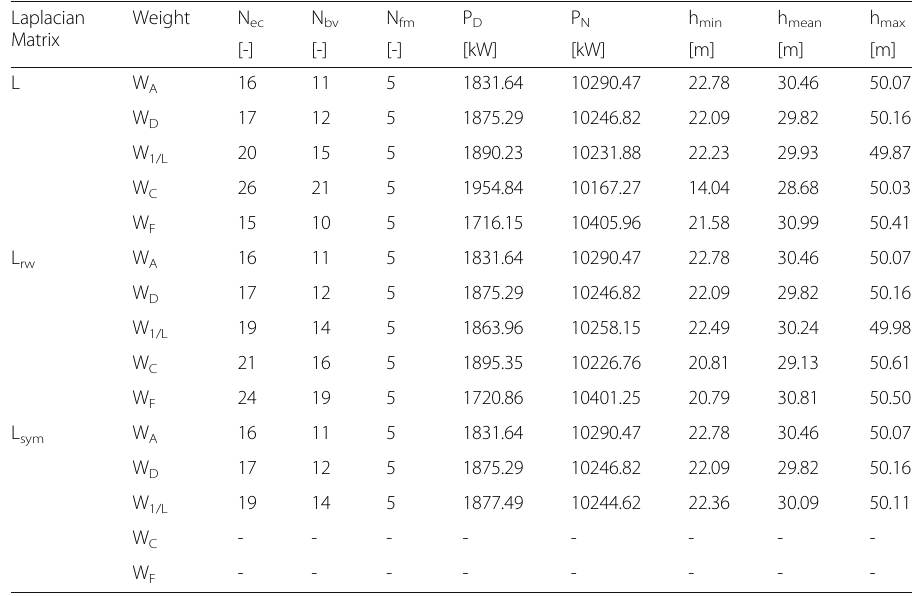
Table 5 Hydraulic performance indices after the dividing phase for the three tested algorithms and the five adopted pipe